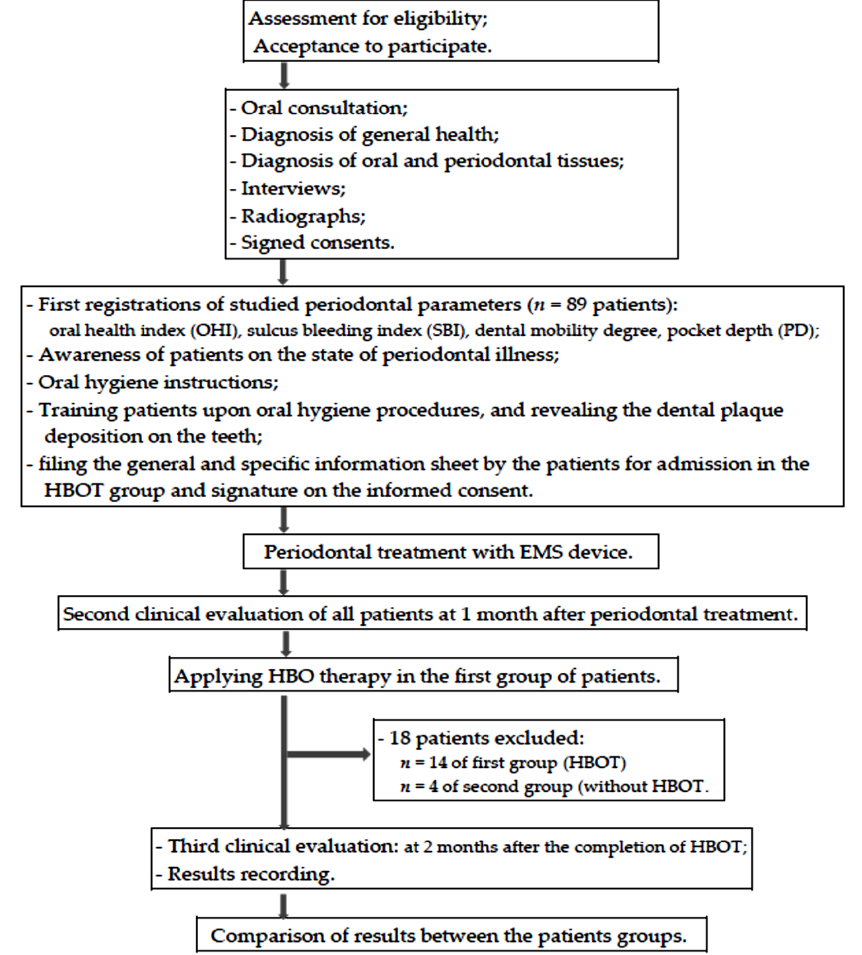
Figure 2. Flow chart of the clinical study.